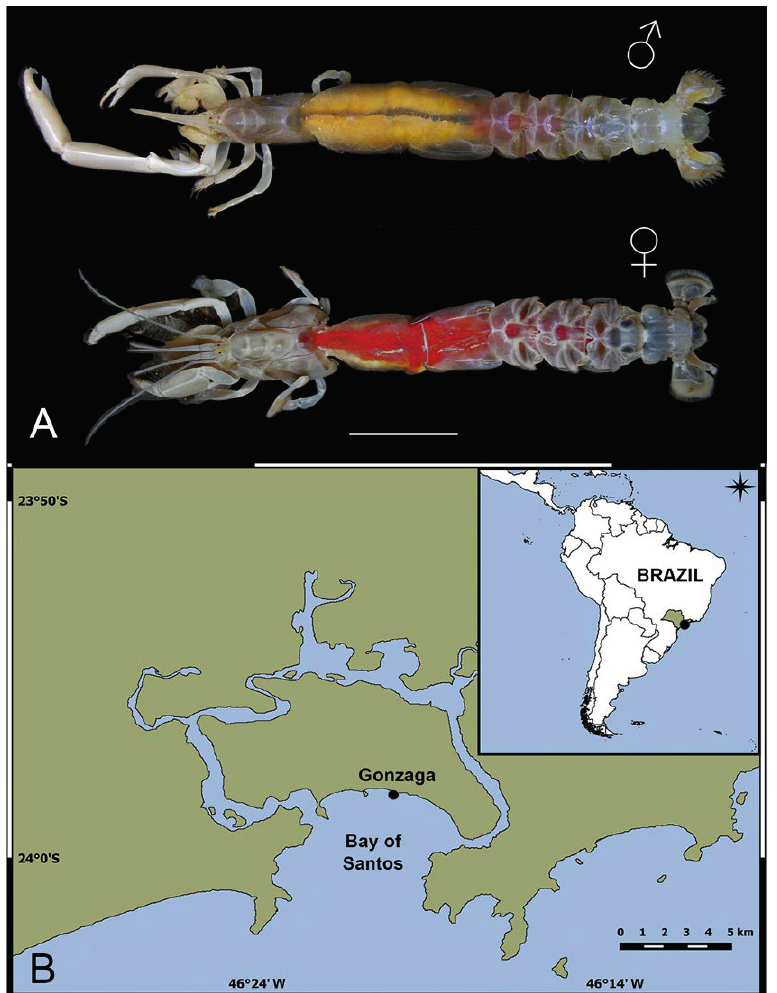
Fig. 1. – Dorsal view of male and female individuals of the ghost shrimp C. major (A). Geographical position of the study area (B). Scale bar = 1 cm.